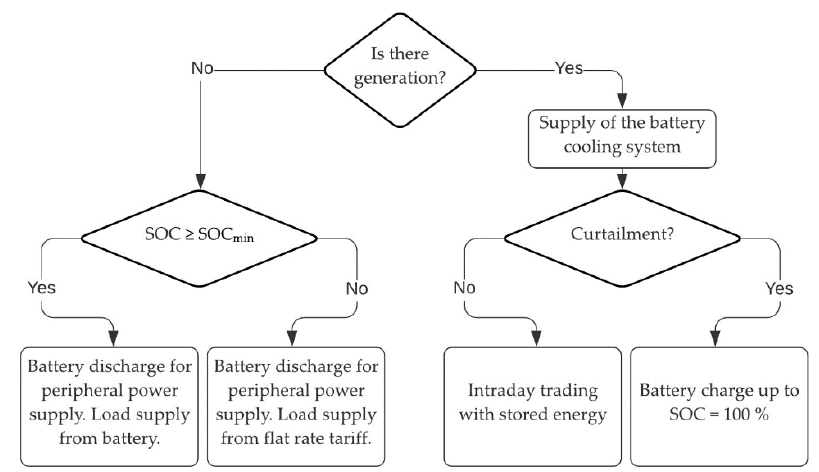
Figure 8. Operation procedure of the PV farm in Germany with BES—study case B. The BES control takes place in strictly defined hours related to current unit prices of electricity. The price of energy increases in the afternoon; this is related to the increase in energy consumption.